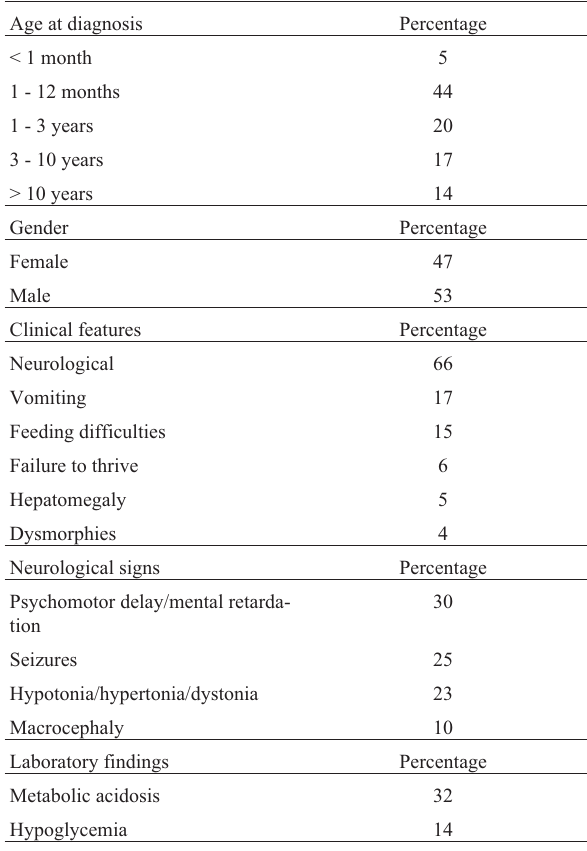
Table 1 - Common features of patients with aminoacidopathies detected in high-risk Brazilians.